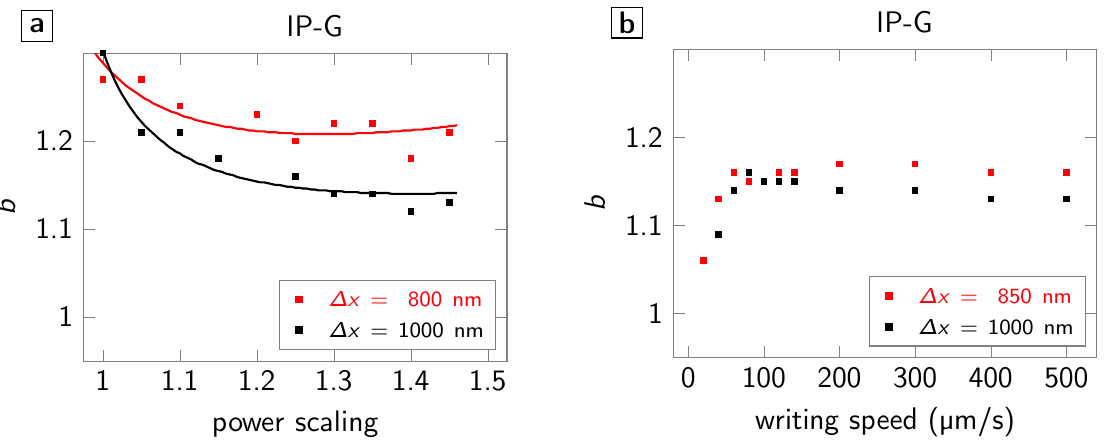
Figure 3. Writing power and speed dependence of the broadening b = w t / w l in IP-G. Squares indicate the measured data. The solid lines are trend lines given as a guide to the eye. ( a ) Dependence of b on incident laser power; and ( b ) dependence of b on writing